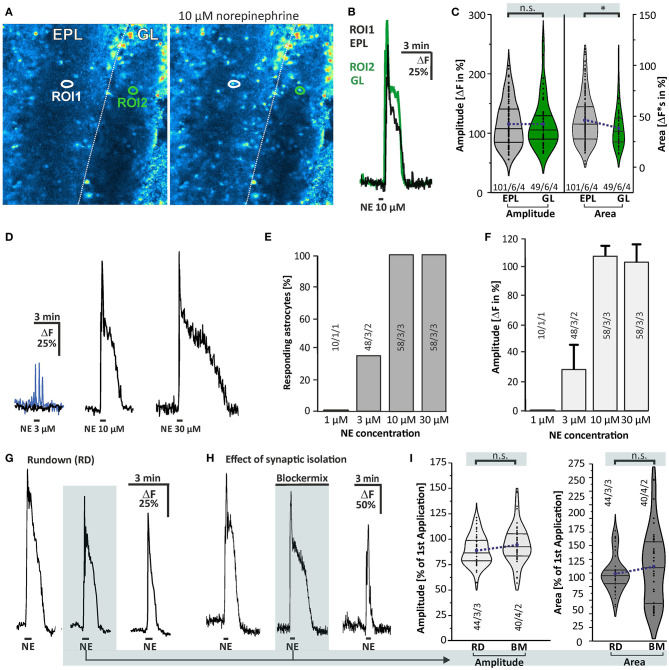
Norepinephrine-induced calcium transients in olfactory bulb astrocytes. (A) Fluo-8 staining of acute olfactory bulb slices with example ROIs shown in idle state (left) and in the presence of 10 μM norepinephrine (right). (B) Example traces of cells located in the external plexiform layer (EPL; ROI1, black trace) and in the glomerular layer (GL; ROI2, green trace). (C) Violin plots of amplitude (left) and area (right) of norepinephrine-induced calcium responses in EPL (gray) and GL (green) (see section Materials and Methods for details). Sample size as specified: cells/slices/animals. n.s., not significant. *p < 0.05. (D) Dose-response relationship of calcium transients evoked by norepinephrine (NE). At 3 μM NE, most astrocytes did not respond with Ca2+ transients (black trace), while some astrocytes generated a small Ca2+ rise (blue trace). (E) 1 μM NE failed to trigger calcium transients in astrocytes, while 3 μM evoked a Ca2+ response in about one-third of the astrocytes. Ten micromolars of NE was sufficient to induce calcium transients in all astrocytes investigated, with (F) maximal amplitude. (G) Example of multiple applications of NE (10 μM) with a 10-min interval displaying a significant signal rundown. (H) Calcium transients were not affected in presence of tertodotoxin (TTX), GABAergic, glutamatergic, and purinergic antagonists (Blockermix contains: NBQX 10 μM, D-APV 50 μM, gabazine 10 μM, CGP55845 10 μM, MPEP 2 μM, MRS2179 50 μM, ZM241385 0.5 μM, TTX 1 μM). For statistical analyses, the second application in blockermix was compared to the second application in the rundown experiment [depicted in (G)]. (I) Ca2+ responses by the second application of NE were normalized to responses of the first application, set to 100%. Amplitudes (left) and area (right) of calcium responses compared between the rundown experiment, i.e., in the absence of the blockermix (RD), and in presence of the blockermix (BM). Both amplitude and area were not significantly different (n.s.).